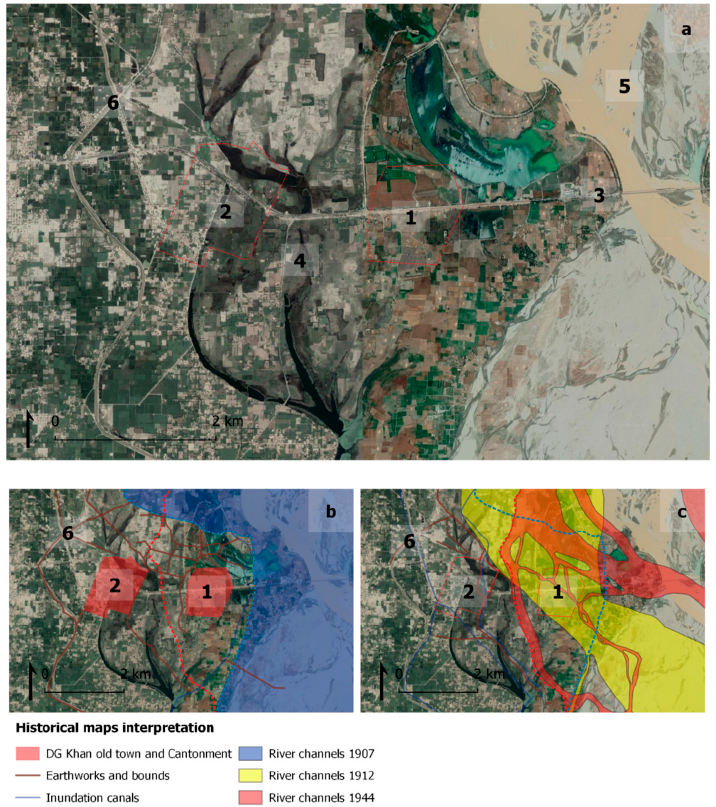
Figure 9. ( a ) Detail of the area of the old DG Khan city in a high-resolution satellite image. Below, superposition of the features extracted from the SoI 1” to 1-mile; ( b ) before the flood (1907 edition) and; ( c ) after (1912 and 1944 editions). The features have been extracted directly from the maps, showing its topographic reliability. That is particularly visible in the right part of the image, less affected by the river movements, where ( 6 ) part of the earthwork morphology has been preserved by canals and the modern road network. The accuracy of the elements preserved in today’s landscape provides a high confidence in the location of disappeared elements. The numbers indicate different areas discussed in detail in the following section: ( 1 ) the old walled DG Khan; ( 2 ) the British cantonment; ( 3 ) the modern N-70 bridge; ( 4 ) depression between the old city and cantonment and; ( 5 ) the main Indus channel. In the maps ( b , c ) the river bed according the different SoI editions is superimposed.